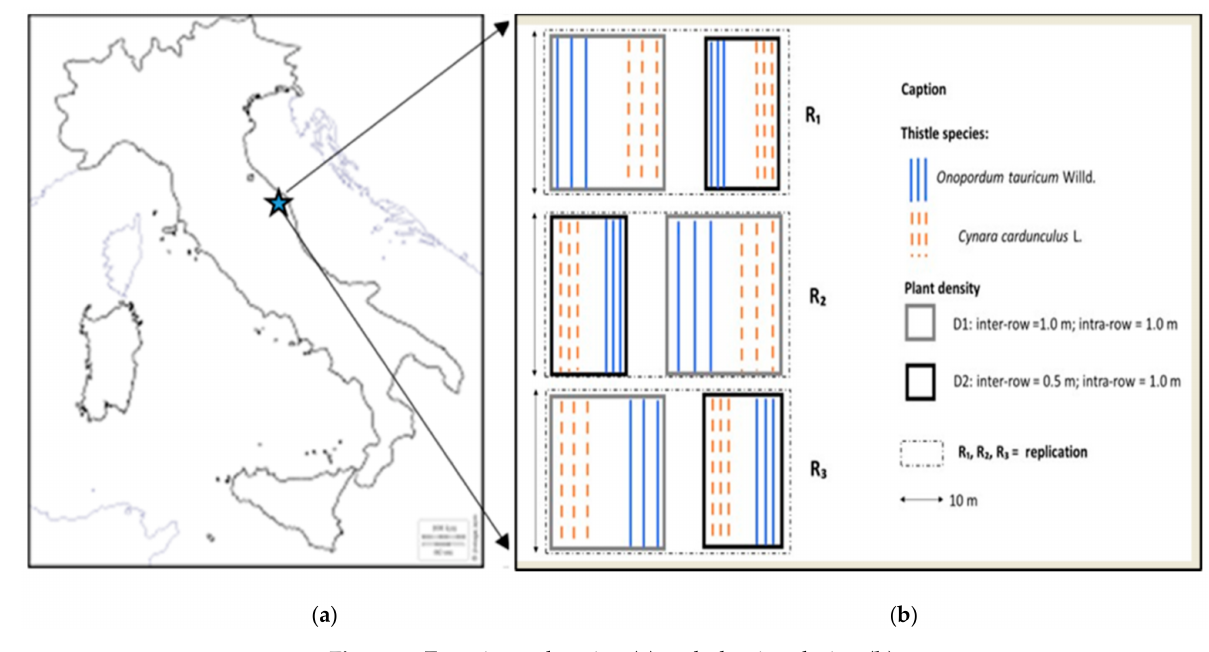
Figure 1. Experiment location ( a ) and planting design ( b ). Table 1. Weather monthly data comparison for temperature (Tavg, Tmax and Tmin ( ◦ C)) and precipitation (mm) in the period 1998–2019 and in 2020 at the experimental